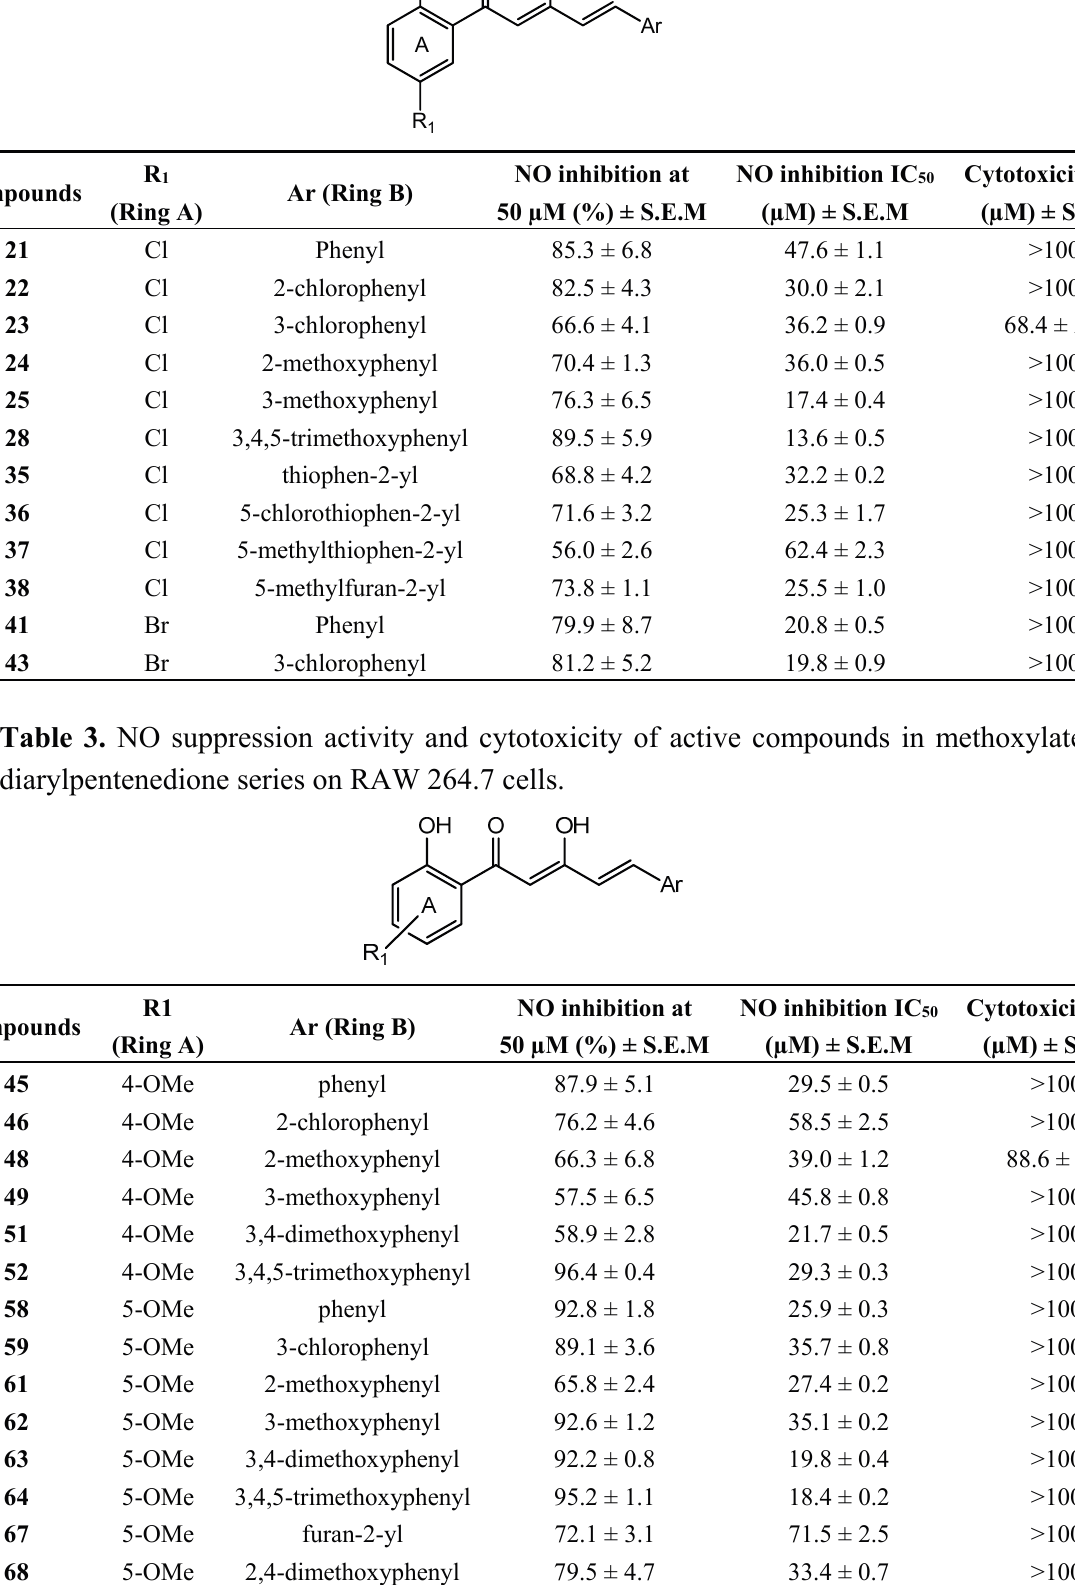
Table 2. NO suppression activity and cytotoxicity of active compounds in halogenated diarylpentenedione series on RAW 264.7 cells.